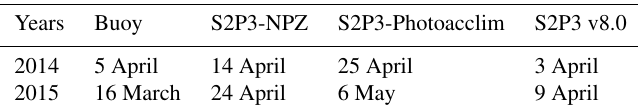
Table B2. Quantitative comparison of the timing of the spring phytoplankton bloom between the buoy observations, S2P3-NPZ, S2P3- Photoacclim, and S2P3 v8.0